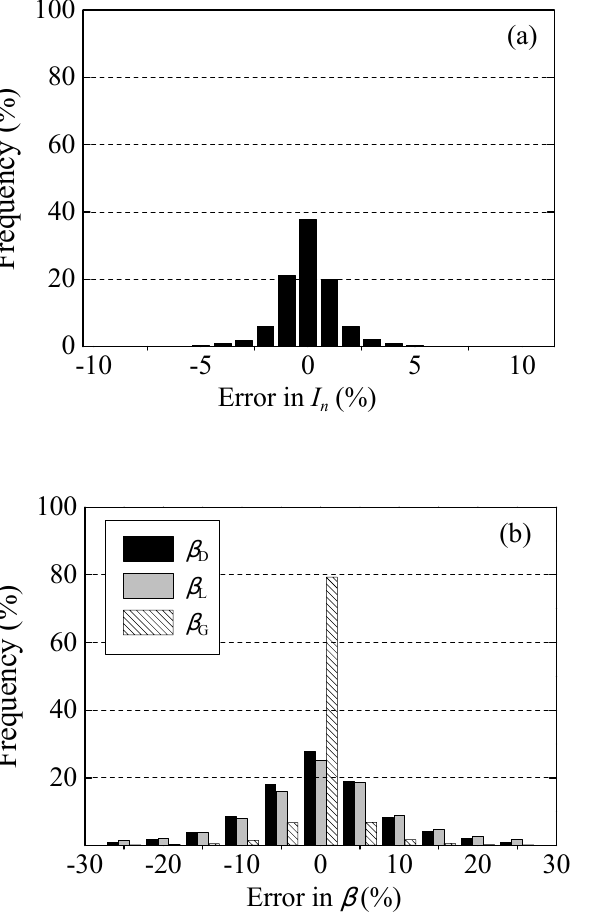
Figure 6 Fig. 6. Percentage frequency distribution of errors in: (a) hourly direct irradiance; (b) turbidity coefficient estimated by each algo- rithm, as pyranometer measurements are affected by a Gaussian random signal.